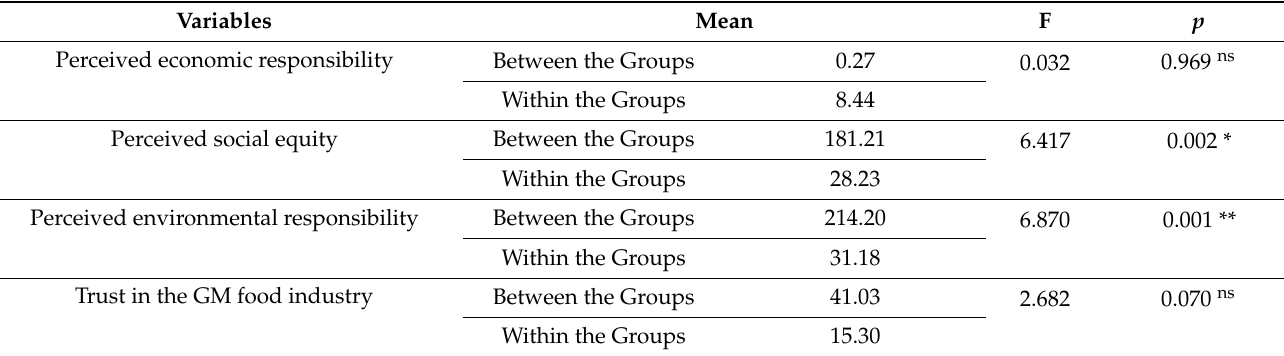
Table 4. Comparison of the variables based on the educational